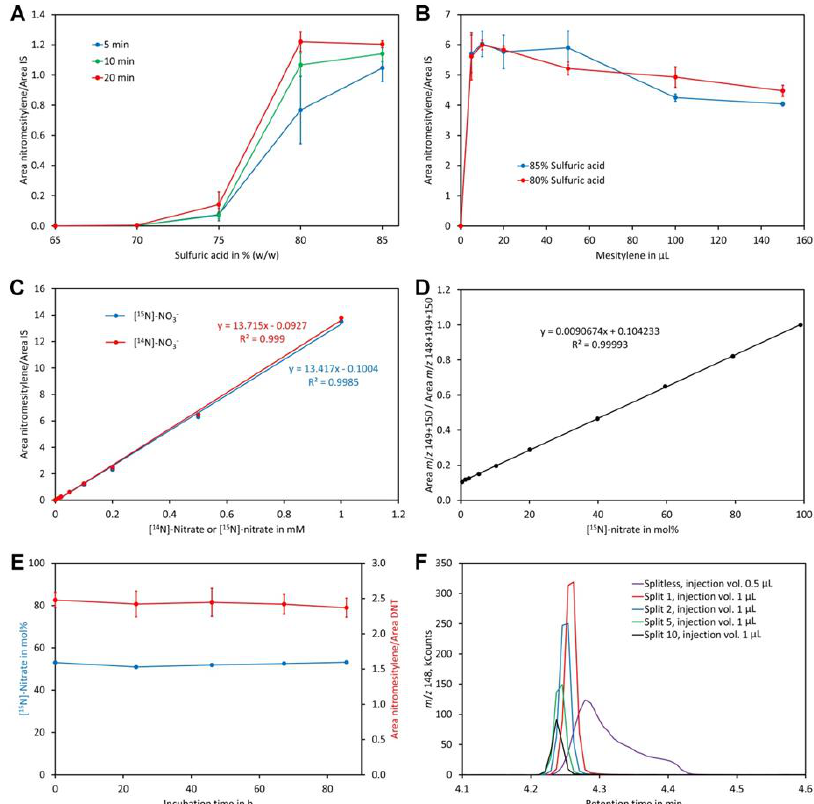
Figure 4. Optimization of the method. ( A ) Reaction time and sulfuric acid concentration. The dots and bars are the average and SD of three replicates, respectively. ( B ) Amount of mesitylene and sulfuric acid concentration. The dots and bars are the average and SD of three replicates, respectively. ( C ) Linearity in the range of 0 to 1 mM [ 14 N]-nitrate and [ 15 N]-nitrate. ( D ) Calibration curve for determination of the [ 15 N]-nitrate level using standards containing 0.2 mM nitrate. ( E ) Stability of the reaction product. The derivatized sample was injected after incubation for the indicated time. The blue dots represent the measured content of [ 15 N]-nitrate in mol% while the red dots represent the ratio of the area of nitromesitylene to the area of the internal standard 2,4-dinitrotoluene (DNT). The dots and bars are the average and SD of five measurements, respectively. ( F ) Testing di ff erent injection modes. The same sample was injected splitless or with a split ratio of 1, 2, 5, or 10. The injection volume was 1 µ L except for splitless injection, where 0.5 µ L was injected. Original data are presented in Supplementary File